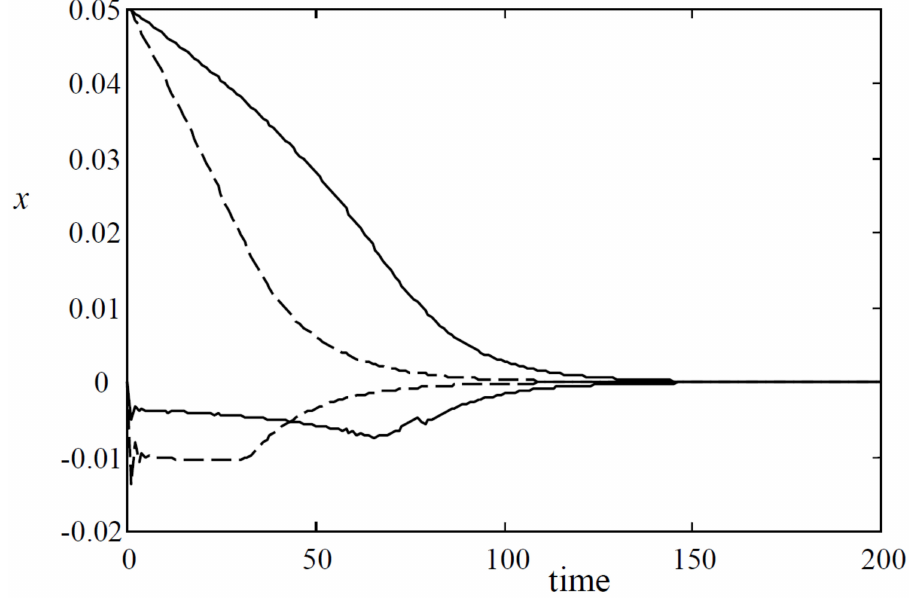
Figure 4. The state responses of the closed-loop systems (dashed line for Algorithm 1, solid Algorithm